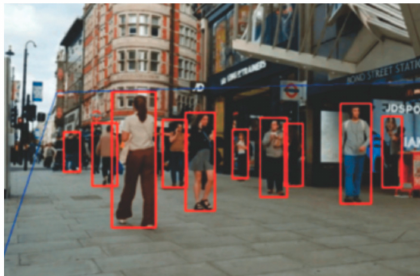
Figure 5. Social distance detection.